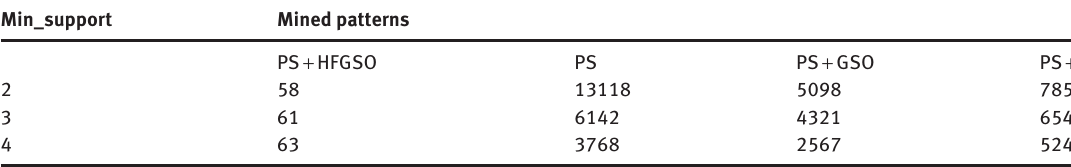
Table 7: Comparative Analysis of the Proposed Approach for Dataset 1.